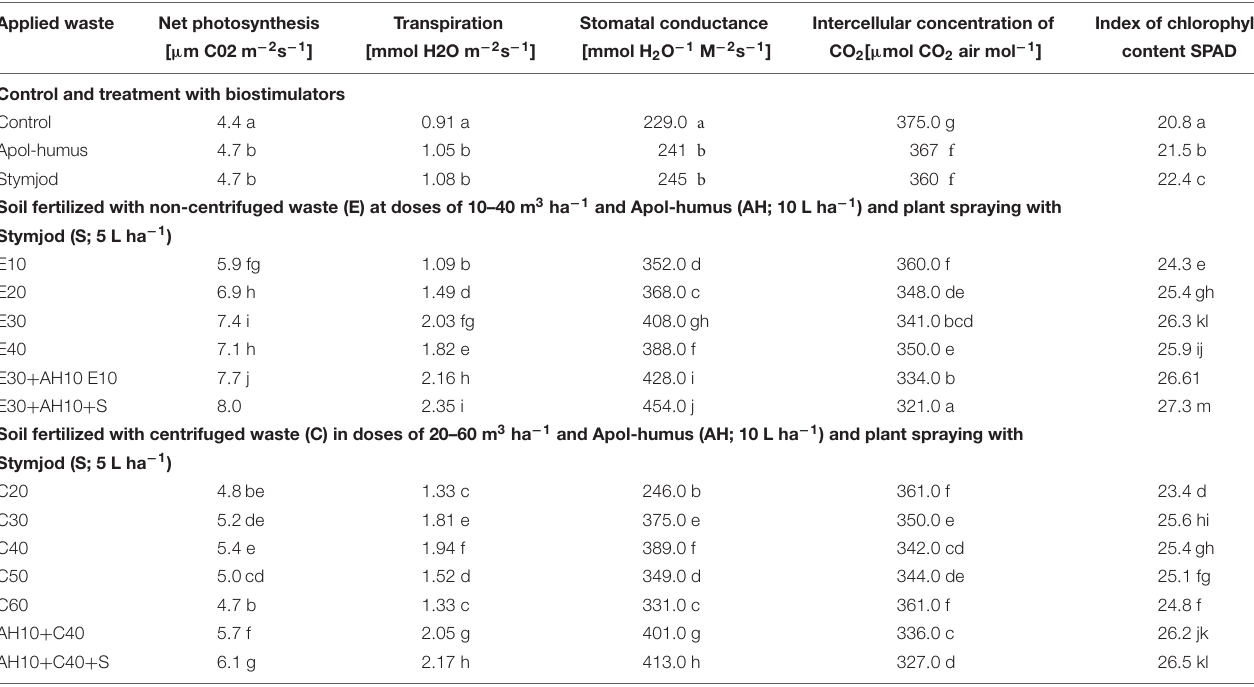
TABLE 3 | Parameters of gas exchange and index of chlorophyll content in sorghum leaves of the plants cultivated in field and fertilized with liquid, non-centrifuged and centrifuged waste from a biomass biodigestion to methane, Apol-humus, and Stymjod. Applied waste Net photosynthesis